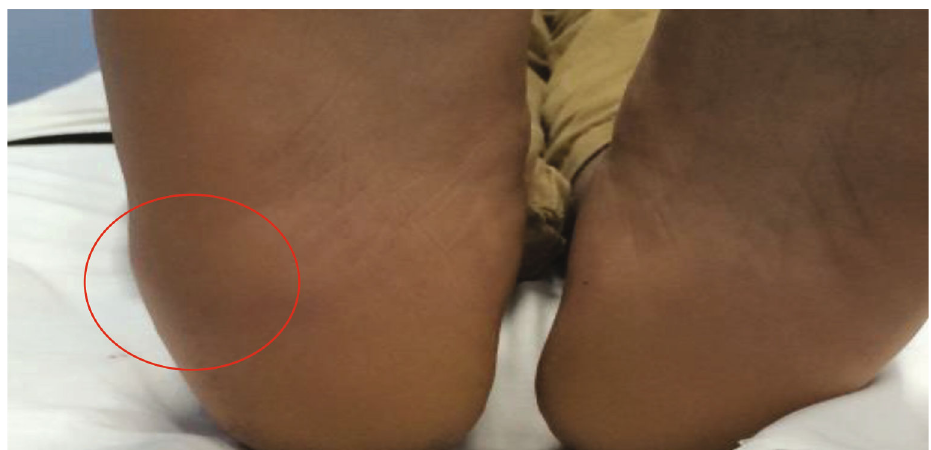
Figure 1: Clinical photograph with red circle showing swelling in the right foot.